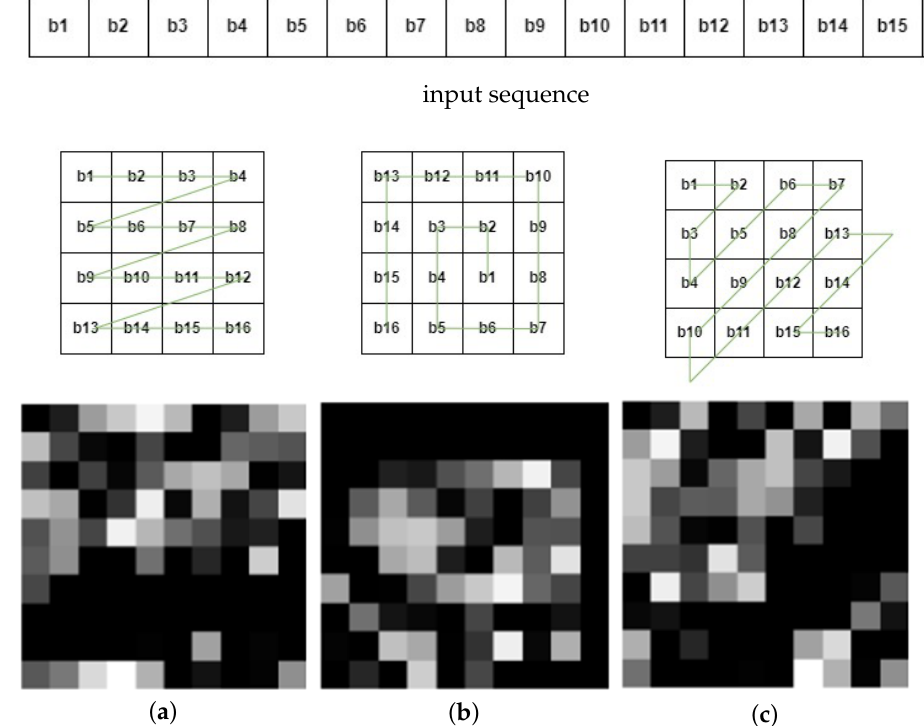
Figure 3. Different schemes for pixel layout: linear ( a ), spiral ( b ), and zig–zag ( c